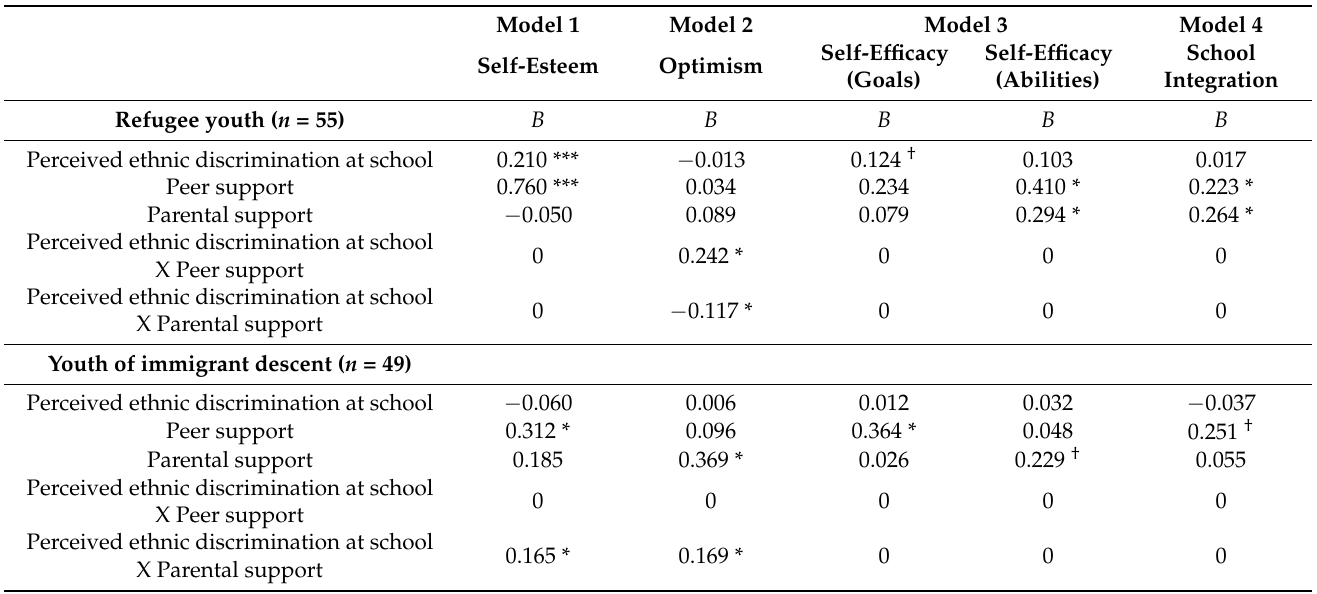
Table 4. Multi-group models comparing refugee youth ( n = 55) and youth of immigrant descent ( n =